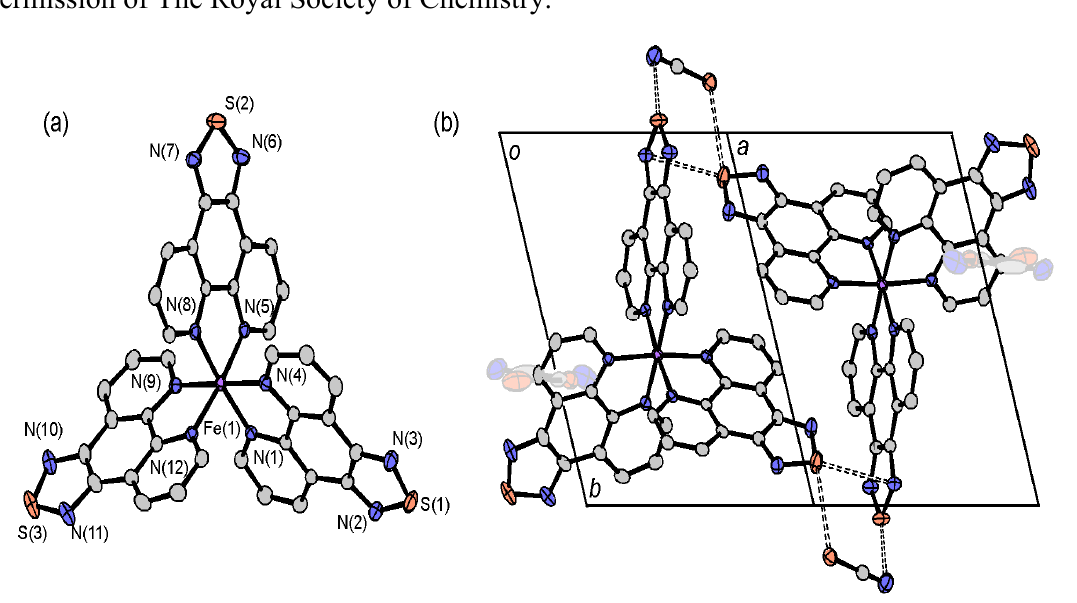
](NCS) [53]. Adapted by 3 2